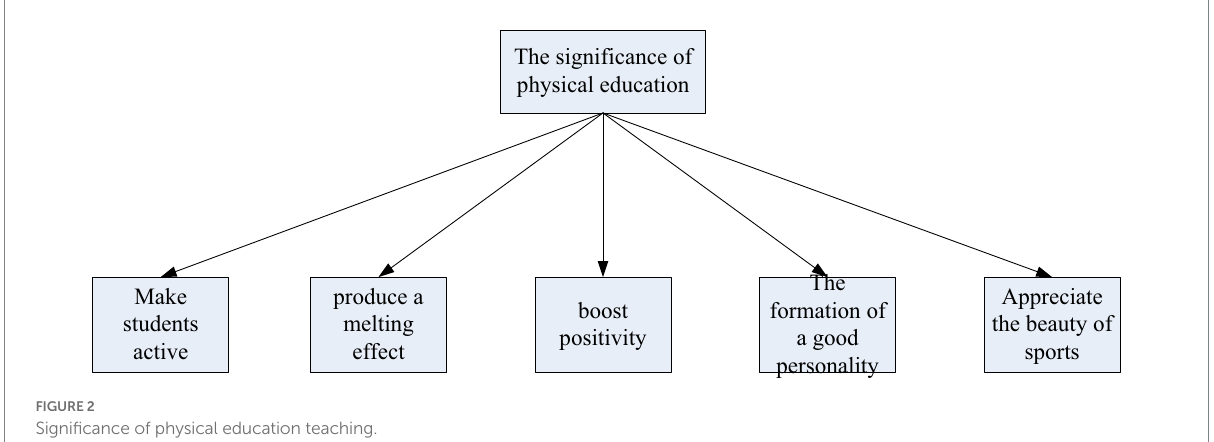
FIGURE 2 Significance of physical education